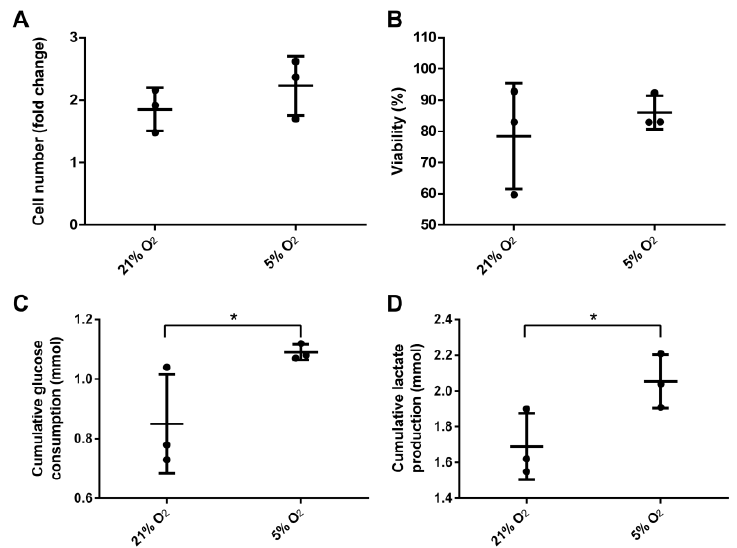
Figure 3. ( A ) Yield of viable cells; ( B ) overall viability, cumulative ( C ) glucose consumption and ( D ) lactate production of mesenchymal stem cells after six days cultivation under 21% and 5% O 2 in a continuously stirred tank reactor ( n = 3). Data is represented as mean ± SD, asterisks indicate statistically significant difference ( p < 0.1, confidence interval of 90%).